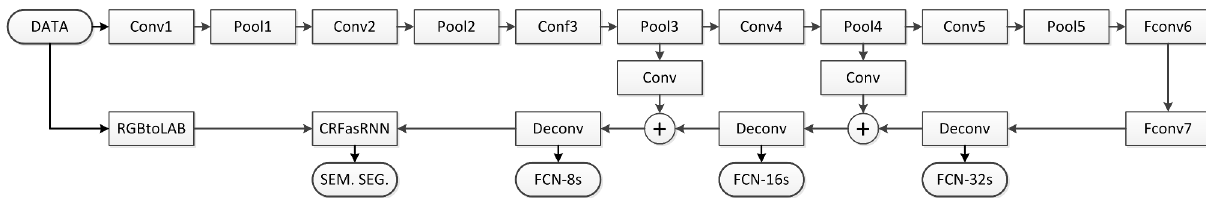
Figure 2. Schematic overview of the Neural Network: The network consists of (fully) convolutional, pooling and deconvolutional layers. Further, the option of early exit exists, which results in coarse semantic segmentations (FCN-XXs). The pixel accurate segmentation (SEM. SEG.) is attained by adding an RGB to LAB color space conversion (RGBtoLAB) and a conditional random field represented as recurrent neural network